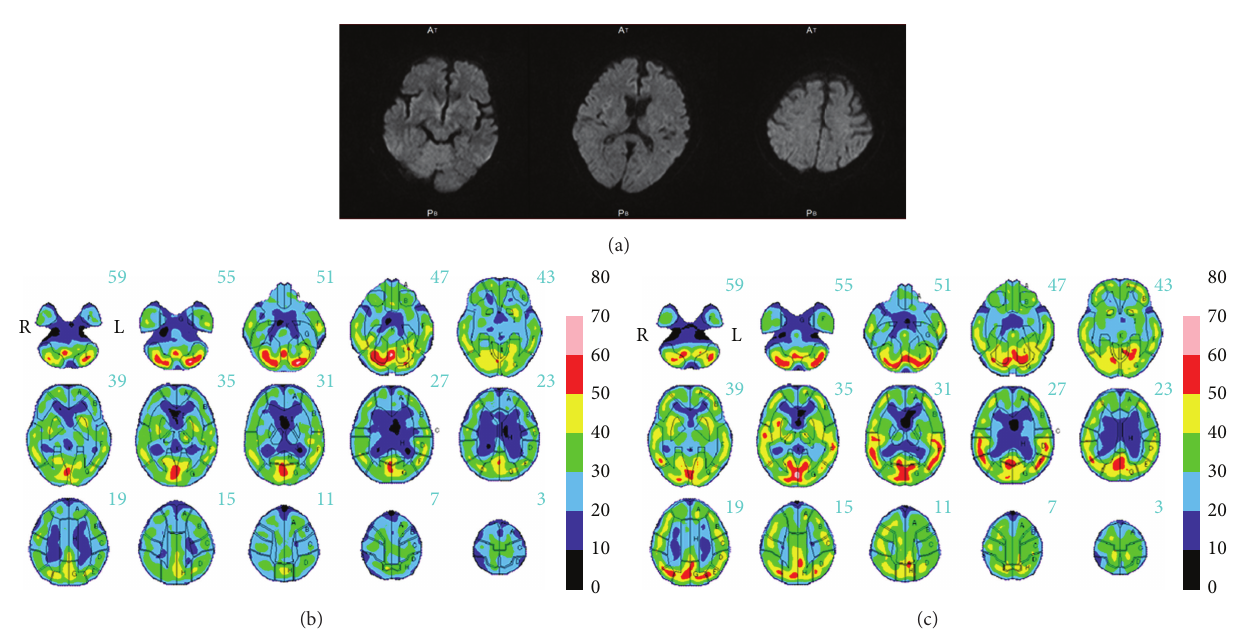
Figure 1: (a) Axial diffusion-weighted magnetic resonance images of the brain in Case 1 obtained on Day 22, revealing no abnormalities. (b) Single-photon emission computed tomography (SPECT) images of the brain using technetium-99m-ethyl cysteinate dimer, analyzed with a 3-dimensional stereotactic region of interest template (3DSRT), in Case 1 obtained on Day 23, demonstrating multifocal hypoperfusion mainly in the frontal and temporal lobes. (c) Corresponding SPECT images of the same patient obtained on Day 65, showing improvement in hypoperfusion areas to almost normal